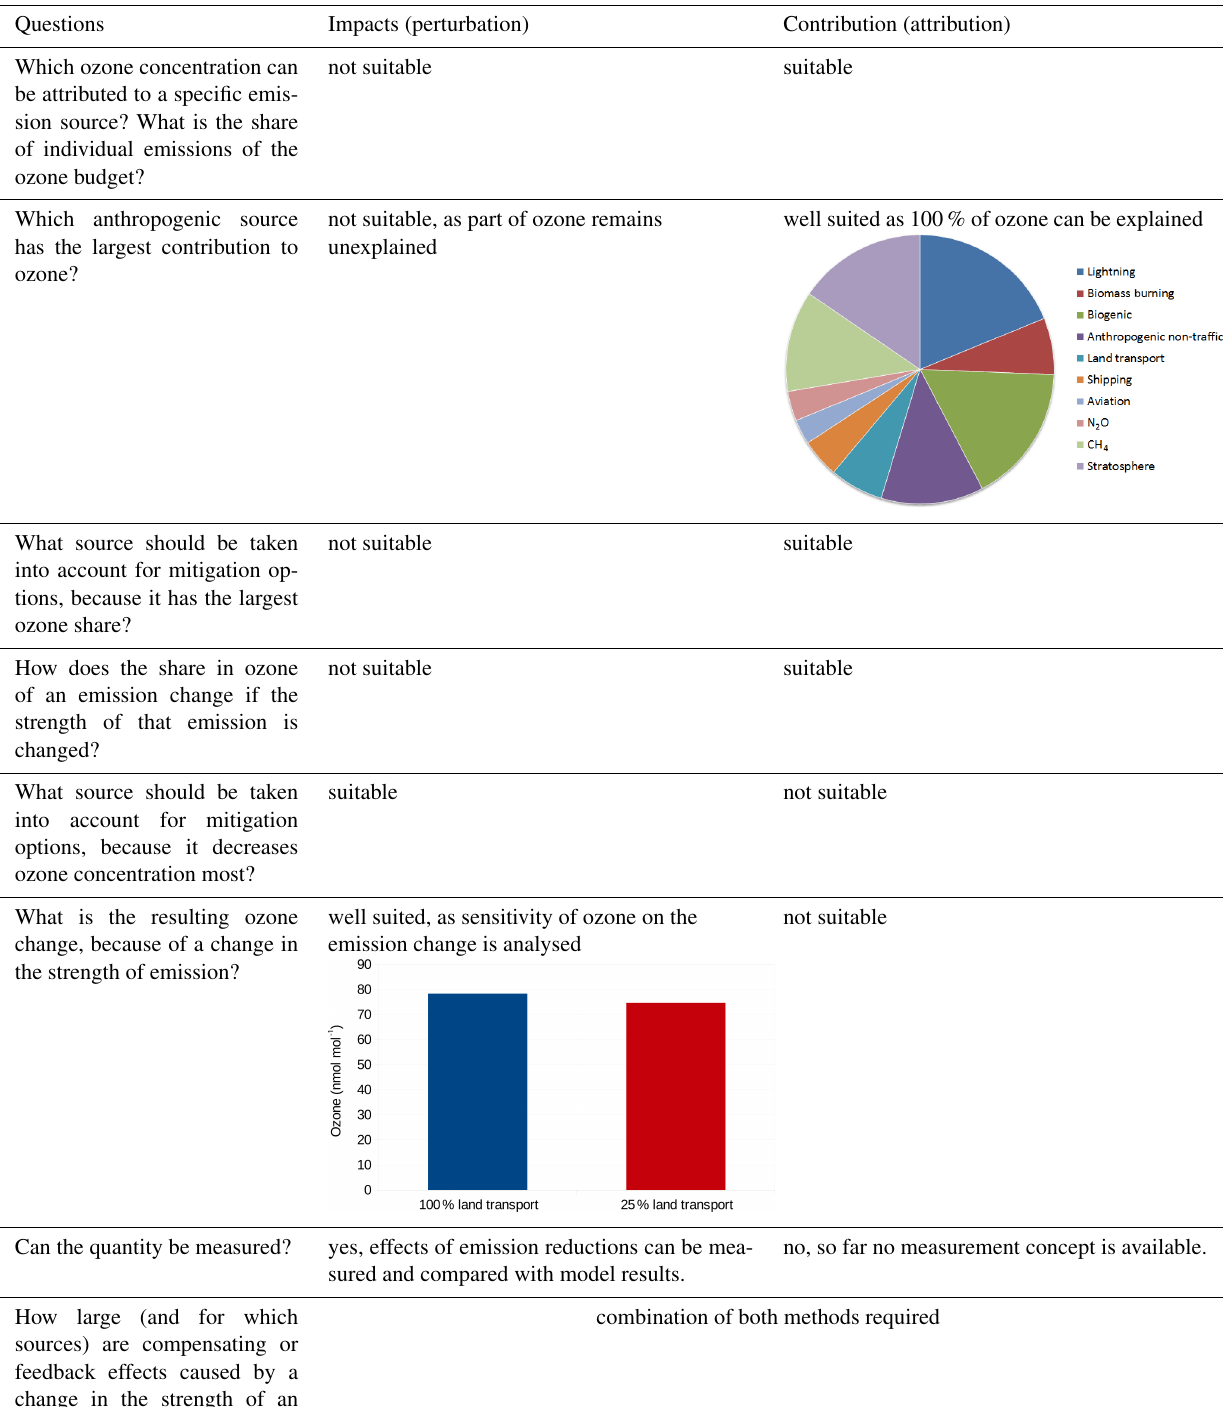
Table 1. Comparison of scientific questions which can be answered by impacts (using a perturbation method) and contributions (calculated by a source attribution method such as